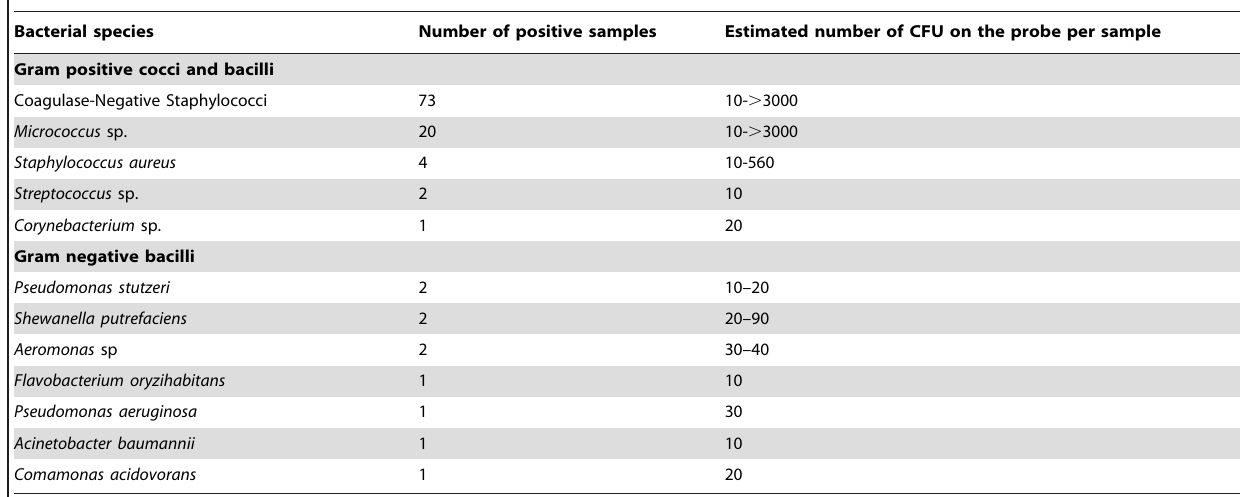
Table 1. Quantification and identification of the bacterial flora present on the